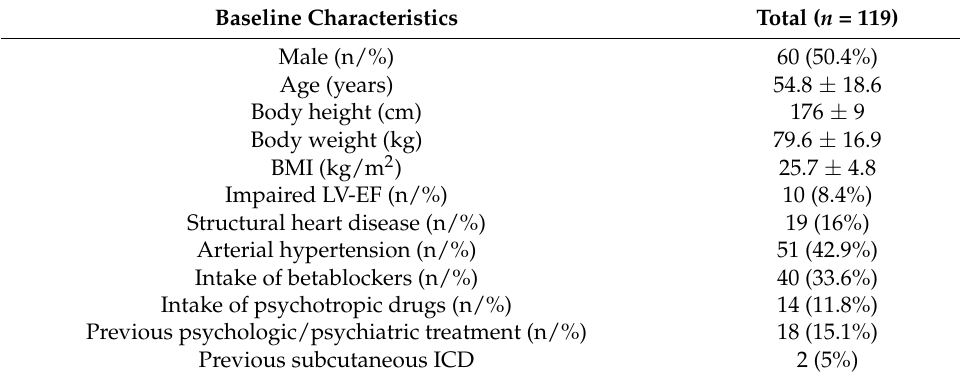
Table 1. Baseline characteristics of the patient cohort